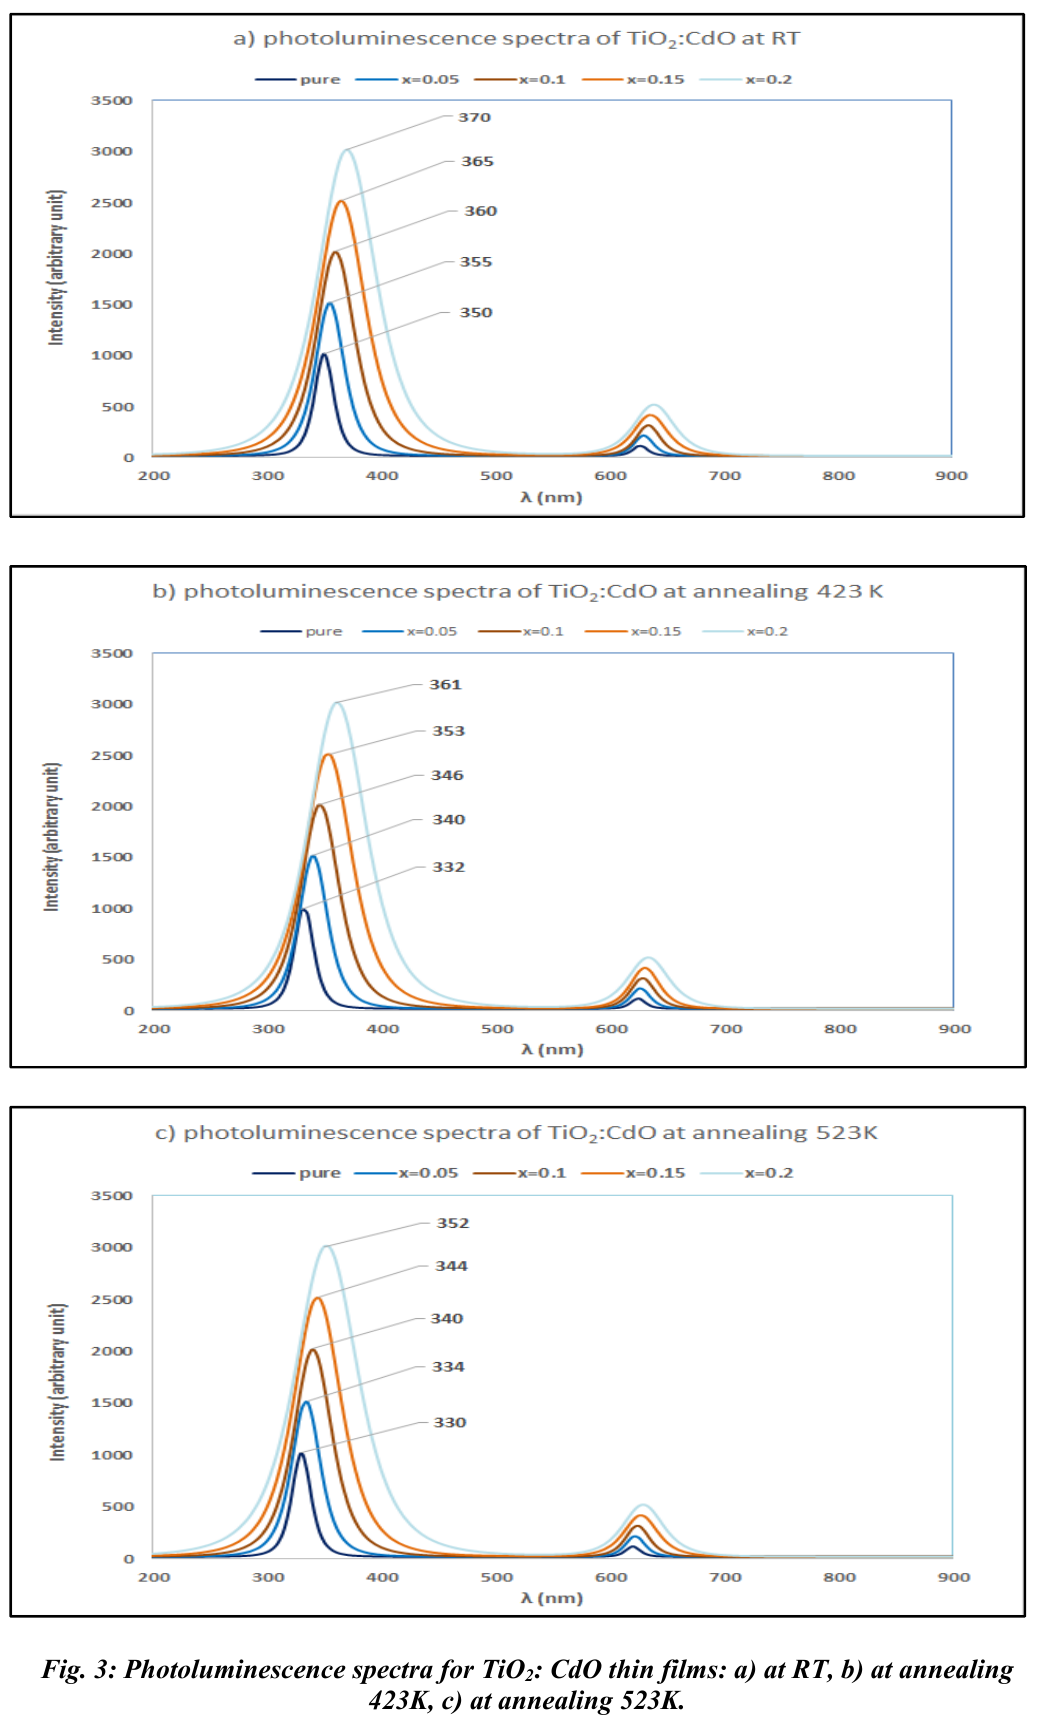
: CdO thin films: a) at RT, b) at annealing 2 423K, c) at annealing